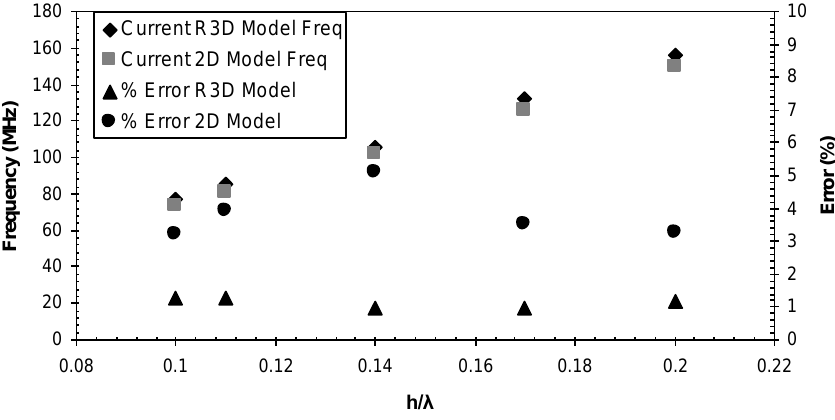
Figure 12. Comparing center frequency values of the current R3D FE model with the current 2D FE model.